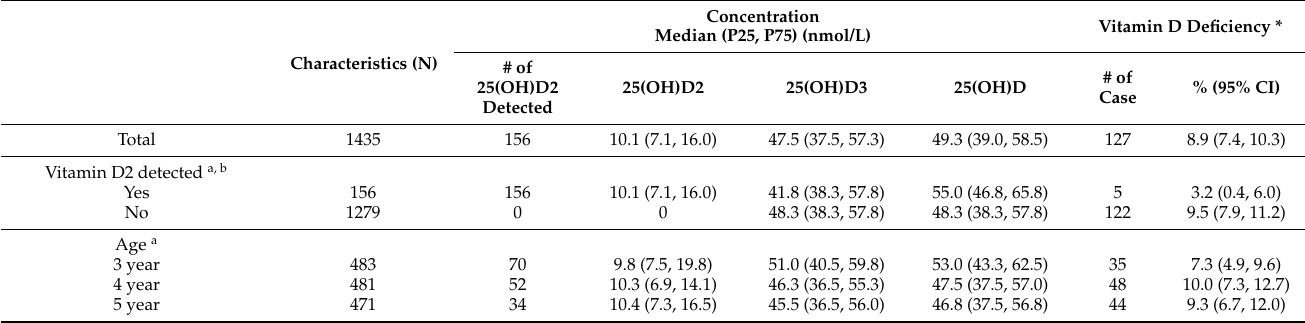
Table 1. Vitamin D status and prevalence of vitamin D deficiency of children by demographic characteristics in China.